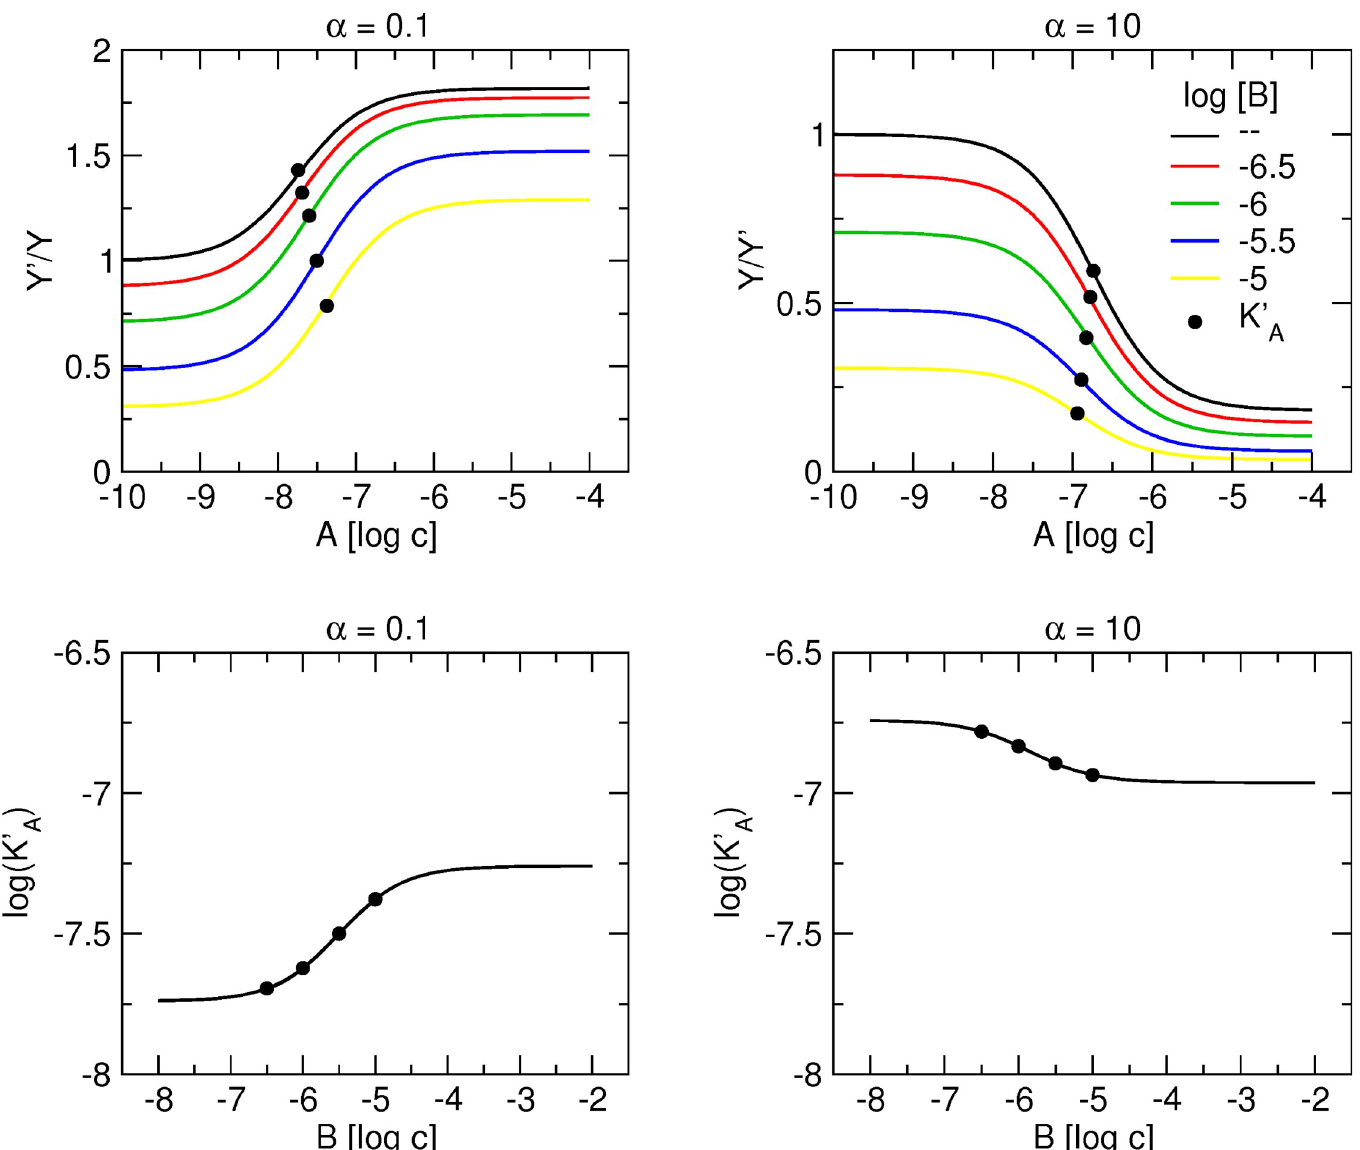
Fig 5. Concentration dependence of the interaction of two allosteric modulators binding each to its own allosteric site. Upper row, simulation of tracer binding (ordinate) in the presence two allosteric modulators A and B each binding to its own site, where A is either positive (left) or negative (right) and B is negative allosteric modulator. Binding of the tracer is expressed as the ratio to the binding in the absence of allosteric modulators. Abscissa, concentration of allosteric modulator A expressed as logarithm of molar concentration. Logarithm of concentration of allosteric modulator B is shown in the graph legend. Simulation parameters: K X = 0.1